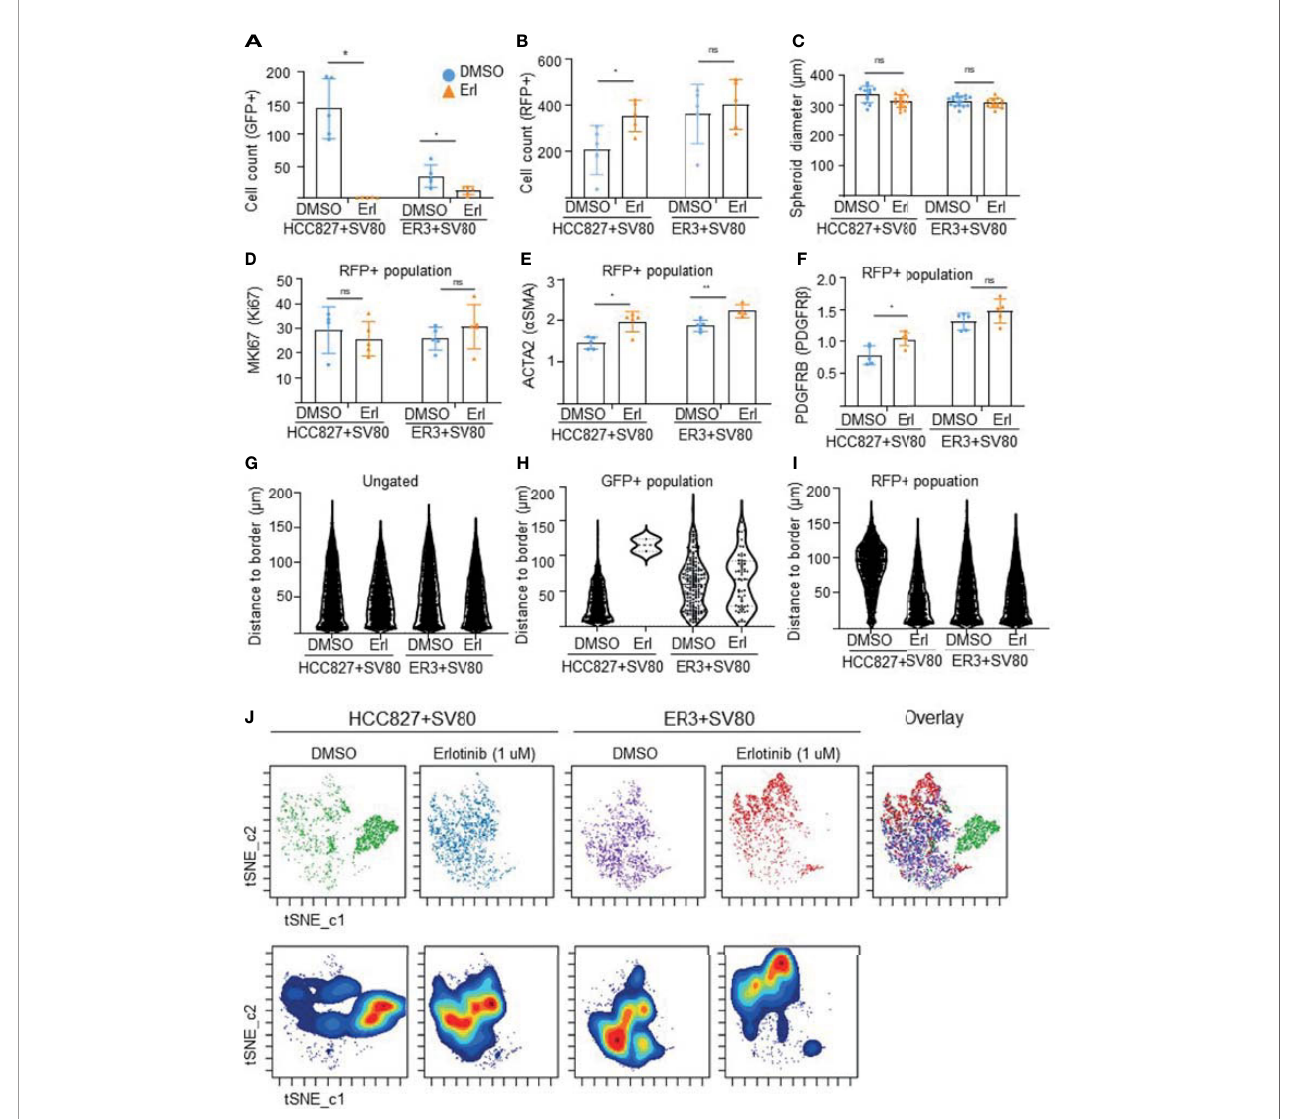
FIGURE 9 | In-depth analysis of imaging mass cytometry data from erlotinib treated spheroids. Absolute cell counts for HCC827+SV80 and ER3+SV80 heterotypic spheroids treated with either vehicle control (DMSO) or erlotinib, respectively. Absolute cell counts for (A) GFP+ cells (cancer cells), and (B) RFP+ cells ( fi broblasts) is shown. Individual values represent median expression of each ROIs, and the mean +/-SD is plotted. Statistical signi fi cance in absolute cell counts were calculated in cytobank using the Mann-Whithey U-test (C) The diameter of erlotinib treated versus vehicle control (DMSO) treated spheroids measured by quantifying H&E-stained images using the measuring tool in Fiji. Mean diameter +/- SD for each condition is shown, and the statistics is performed in GraphPad Prism using the Mann-Whithey U-test. (D – F) Median expression of proliferation marker MKI67 (Ki67) in the nuclei of the RFP+ population (D) . Median expression of ACTA2 ( a SMA) (E) , and PDGFRB (PDGFR b ) (F) in the RFP+ ( fi broblast) populations of HCC827+SV80 and ER3+SV80 heterotypic spheroids treated with either erlotinib or vehicle (DMSO) control. Individual values represent median expression for each ROIs, and the mean +/- SD is plotted. Statistical signi fi cance in channel expression were calculated in cytobank using the Mann-Whithey U-test (G – I) Distance to border measurements displayed as Violin plots for the (G) ungated (all) population, (H) GFP+ population, and (I) RFP+ population. (J) The tSNE algorithm was applied on the ungated population based upon expression of the markers EGFR, CDH1 (E-cadherin), VIM (vimentin), MET (c- Met), pan-cytokeratin, GFP and RFP. viSNE plots displaying the distribution of cells from the different samples. NS = P > 0.05, *P ≤ 0.05, **P ≤